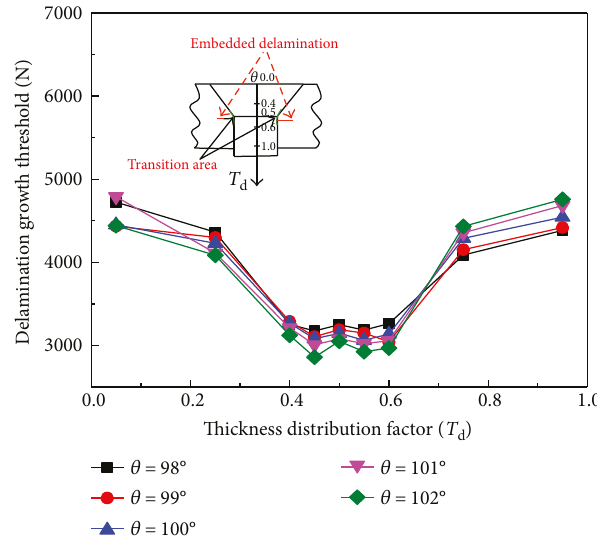
on delamination evolution threshold under d di ff erent countersunk-head angles.